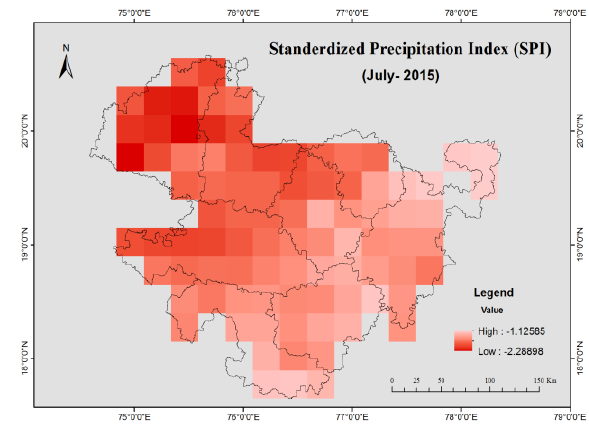
Figure 7. Spatial distribution of Meteorological Drought (2015) Figure 7 shows the spatial distribution of Meteorological drought (SPI) over the Marathwada. The negative values of SPI vary from -1.12 to -2.28 which represent the moderate to extreme drought condition over the whole study area. Aurangabad was the district with highest negative values of SPI followed by Beed and Jalna. Figure 8 represents the annual vegetation condition of 2015 over the Marathwada where 62% of the area was under severe to extreme drought condition. Nanded, Aurangabad, Jalna and Parbhani were the districts with highest vegetation drought severity.